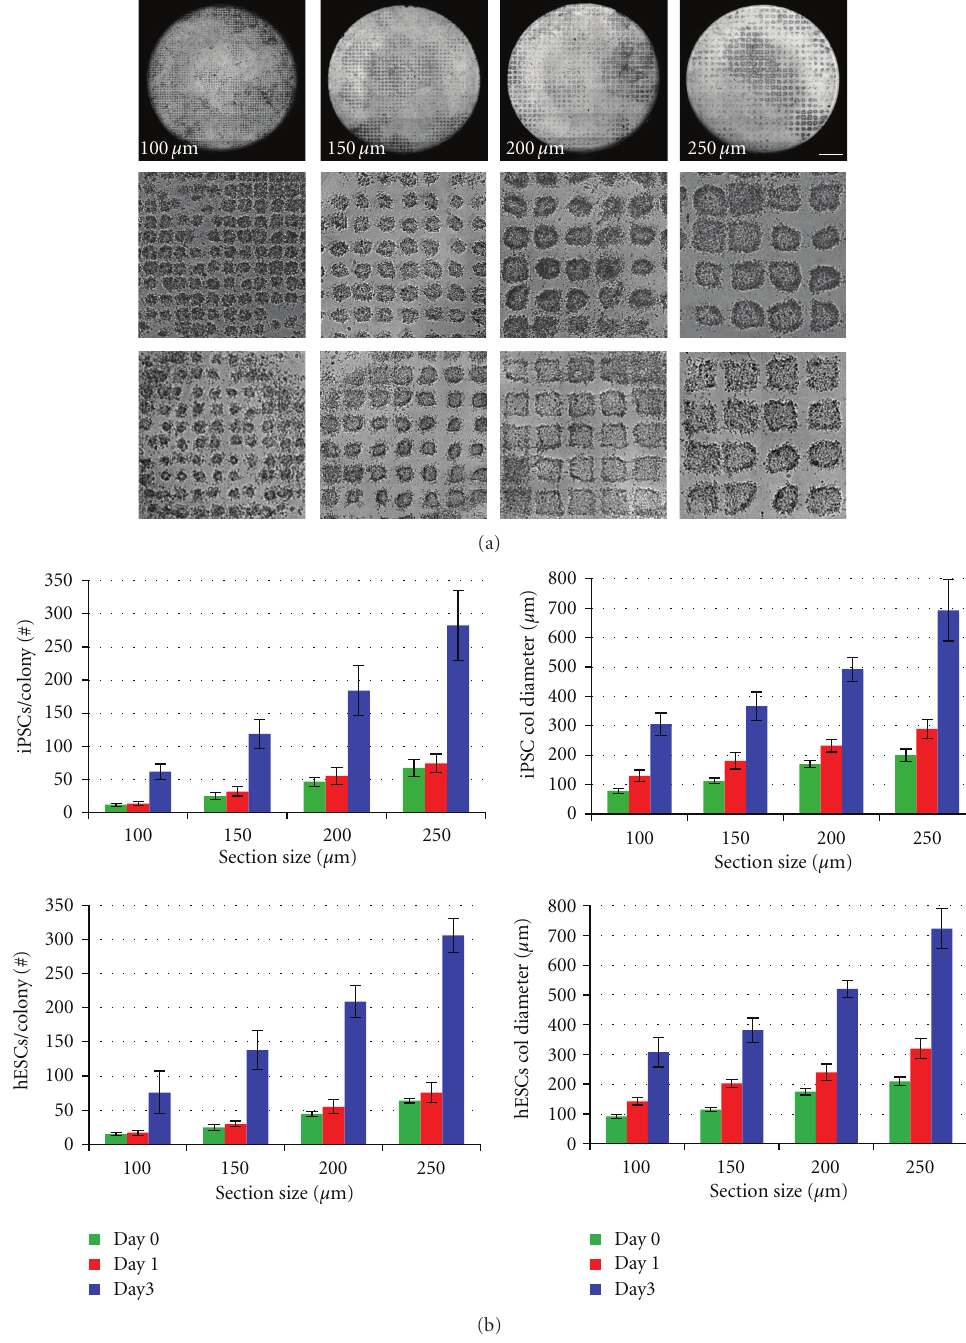
Figure 1: Stem cell colony size was controlled by section size using laser-mediated passage. (a) Brightfield images of human iPSC (top, middle) and ESC (bottom) cultures cut into 100–250 μ m sections. Scale bar, 1 mm. (b) Colony size over time following propagation of 100– 250 μ m iPSC sections (top) or ESC sections (bottom) by laser-mediated passage. Number of cells per colony were manually counted using Hoechst stained cultures (left, n = 15 colonies per data point). Longest diameter of each colony was manually measured using brightfield images (right, n = 15 colonies per data point). Data are shown as mean +